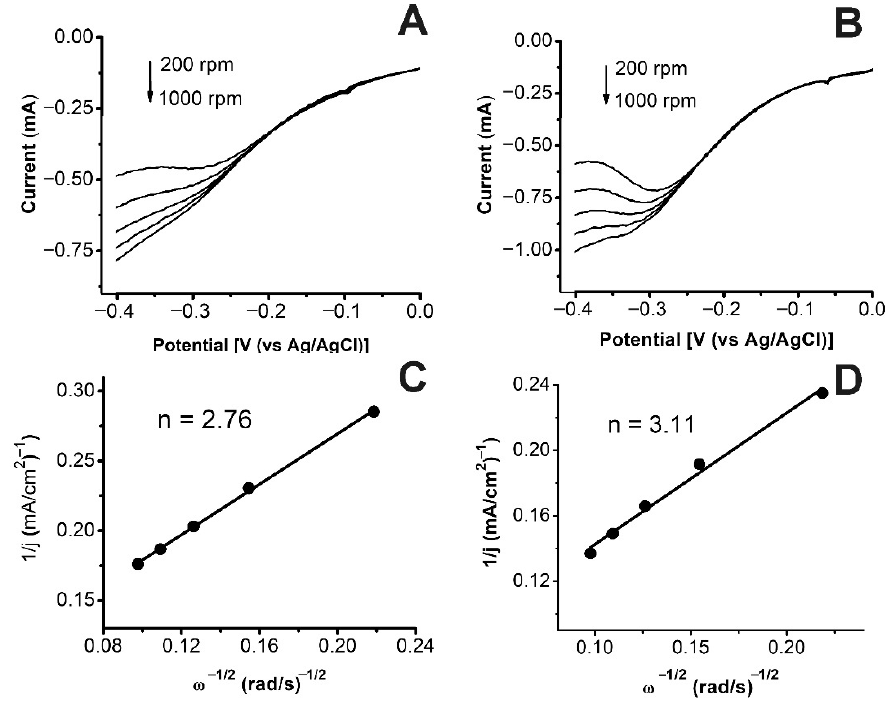
Figure 5. The first halves of the CVs ( A , B ) measured at different speeds of the RDE, the dependencies of Koutecky–Levich at − 0.4 V ( C , D ), corresponding to the Ni(15%)-NaPG/C ( A , C ) and Ni(20%)- NaPG/C ( B , D ) composites in 0.5 M H 2 SO 4 solution.